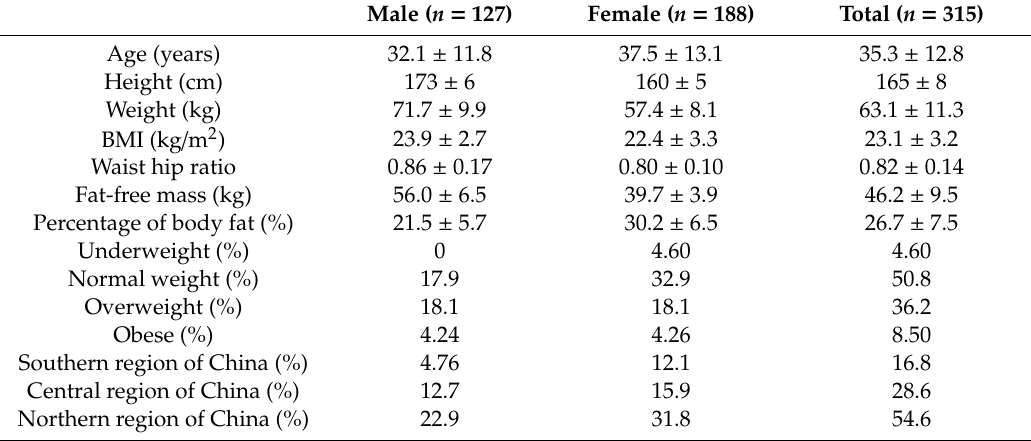
Table 2. Demographic, anthropometric, and body-composition variables of subjects ( n =